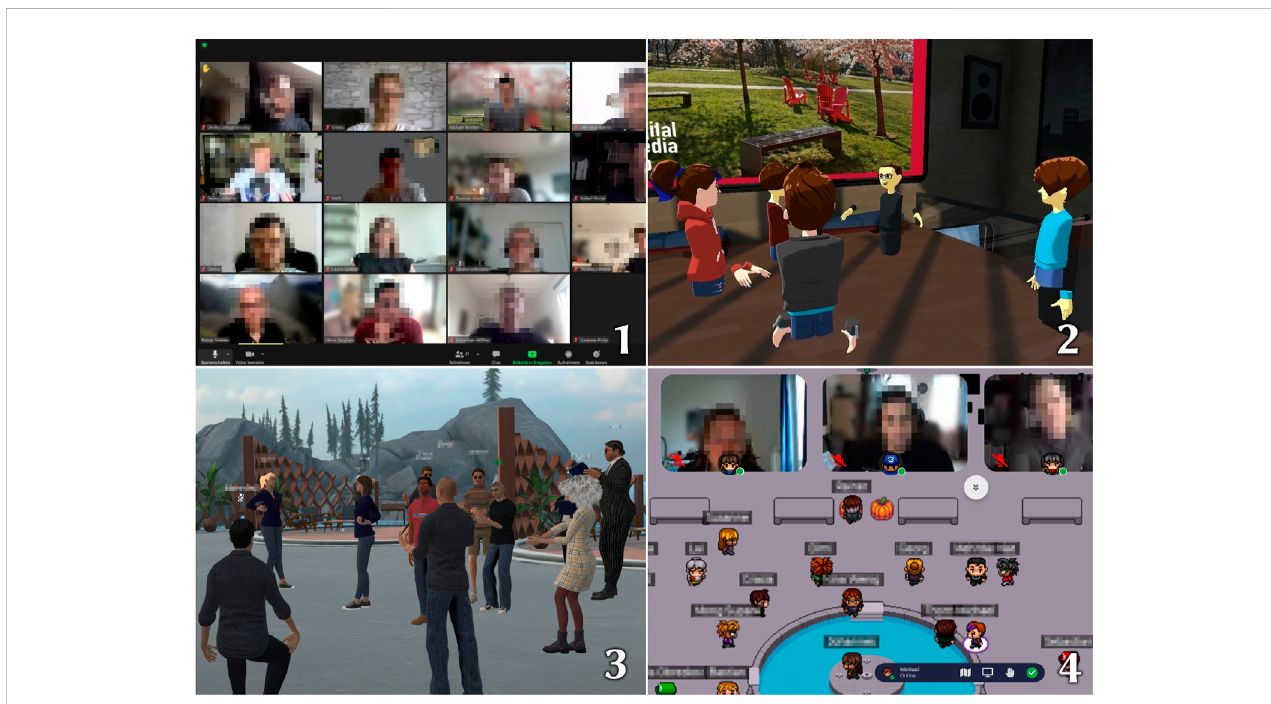
FIGURE 1 The off-the-shelf platforms compared in the wild for our weekly team meetings: (1) Our status quo , Zoom, compared to the two virtual reality platforms (2)AltspaceVRand(3)Engage,aswellasthehybrid(4)GatherTowncombiningvideofeedswithaspatialenvironment.StarLeafwasalsousedinthecasestudy but is not shown here as it has a similar interface to